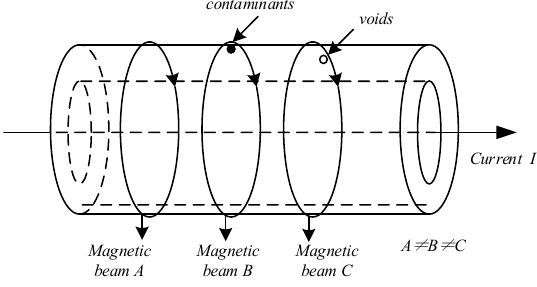
Figure 2. Schematic diagram of uneven magnetic beam in medium.